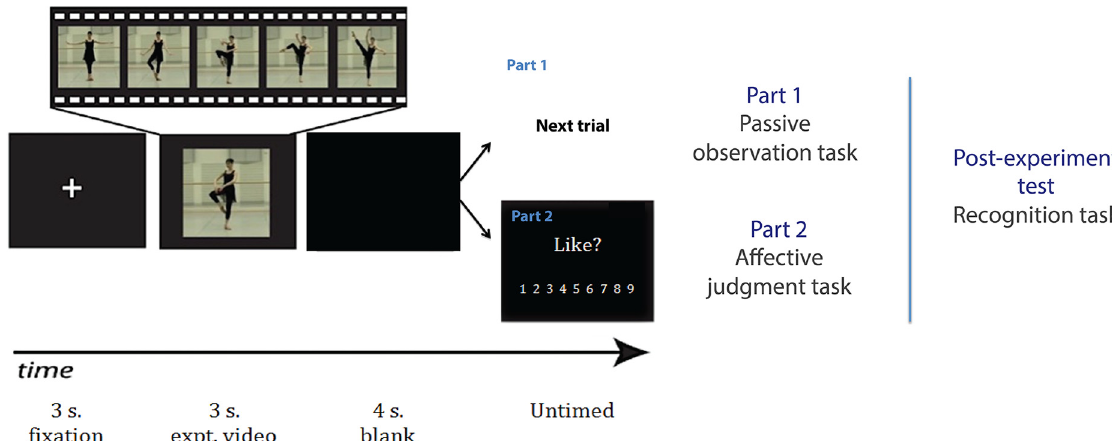
Fig 1. Experimental design. Trials began with a fixation cross that appeared for 3s, followed by a 3s dance sequence and a blank screen for 4s. In Part 1, participants watched the sequences passively, without making any ratings. In Part 2, participants watched each sequence and then rated how much they liked the movement they had viewed. The next trial began after the computer registered a rating. After part 2, participants performed a recognition task, where they watched a number of previously seen and novel dance videos, which they had to decide whether they had seen during the previous task. The dancer whose image appears in the figure consented to the use of her image in research materials and resulting